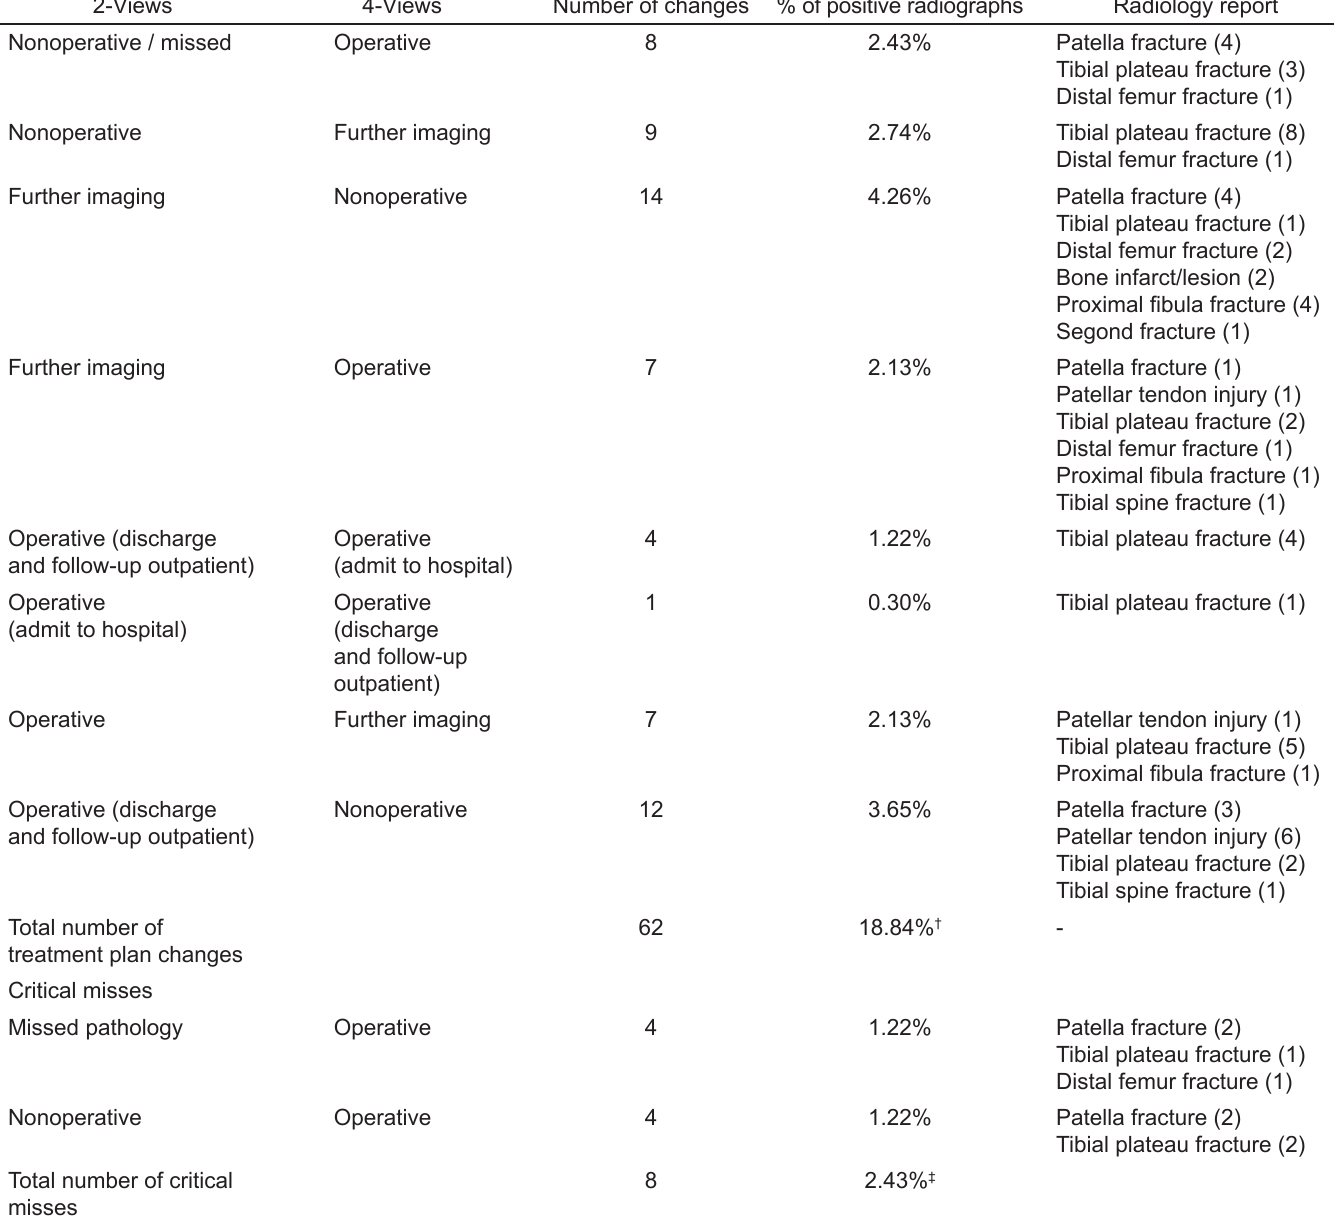
Table 3. Changes in management after the addition of oblique